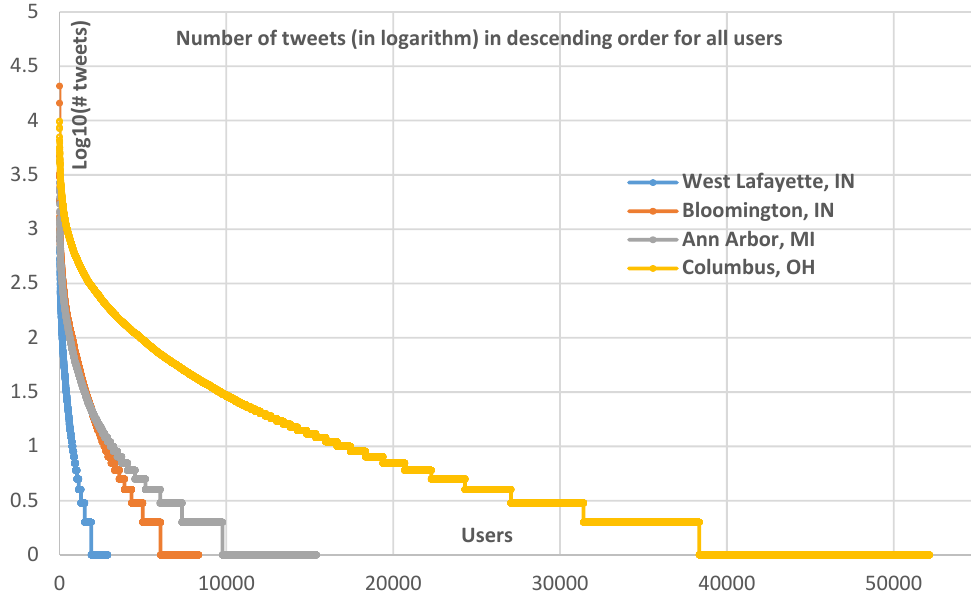
Figure 5. Number of tweets (in logarithm) in descending order for all users.